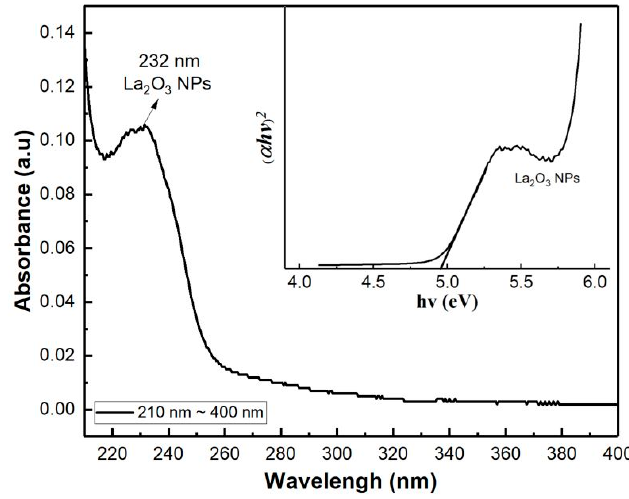
Figure 2. Absorbance spectra of UV–Vis spectrophotometer and band gap calculation using Tauc plot.